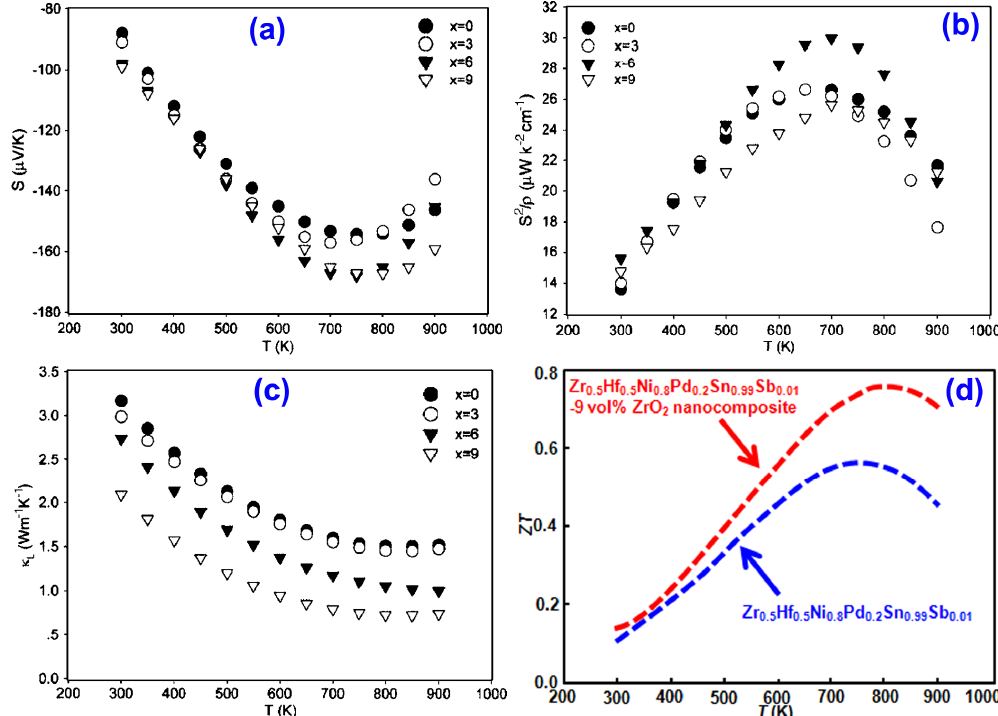
Figure 7. TE transport properties of Zr nanocomposites: ( a ) the Seebeck coefficient; ( b ) power factor; ( c ) lattice thermal conductivity; and ( d ) calculated ZT values for Zr nanoinclusions and with 9 vol% ZrO from Reference [108]. Copyright 2006, American Institute of